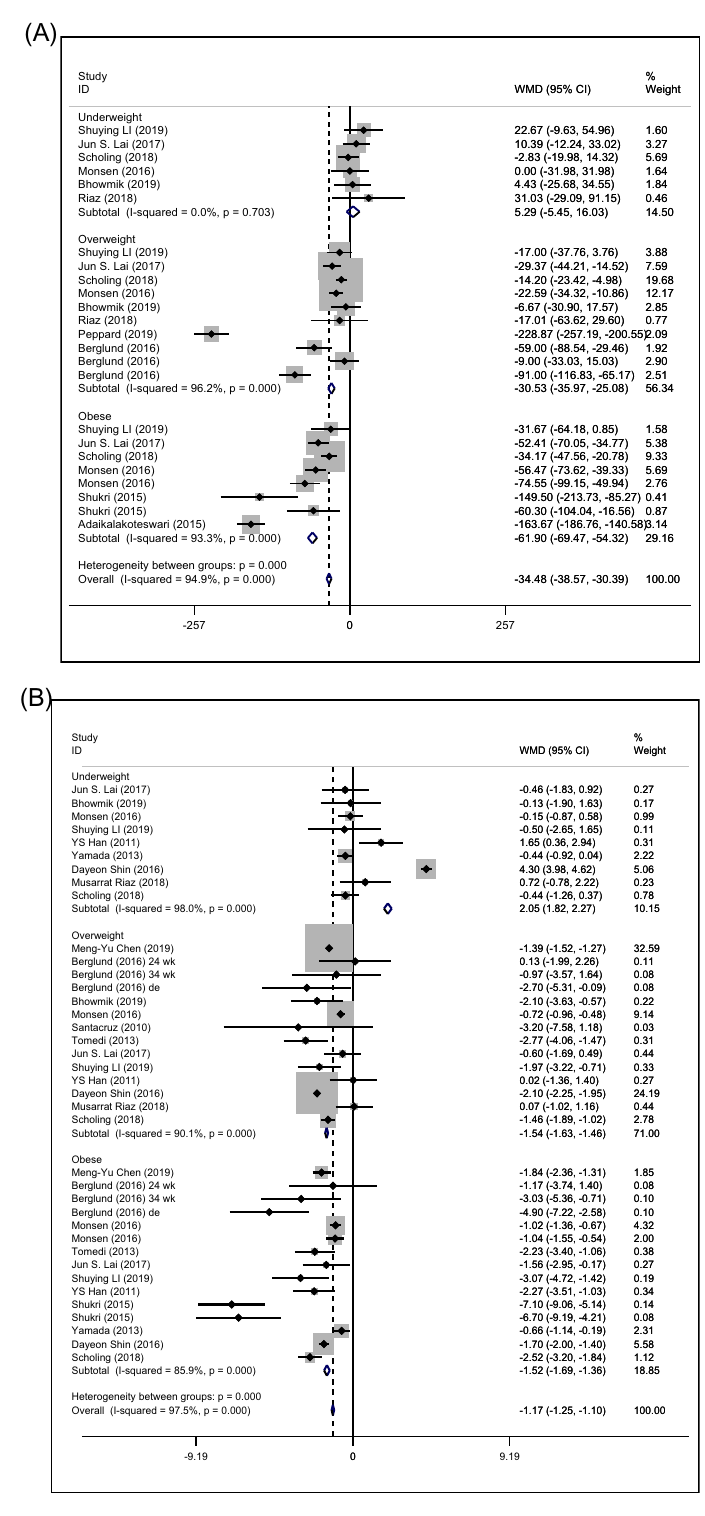
Figure 4. Forest plots between prepregnancy BMI and micronutrient deficiency, including vitamin B12 ( A ), folate ( B ), vitamin D ( C ), iron ( D ) and ferritin ( E ). Subgroup analysis of combined weighted mean differences with 95% confidence intervals was stratified by the prepregnancy